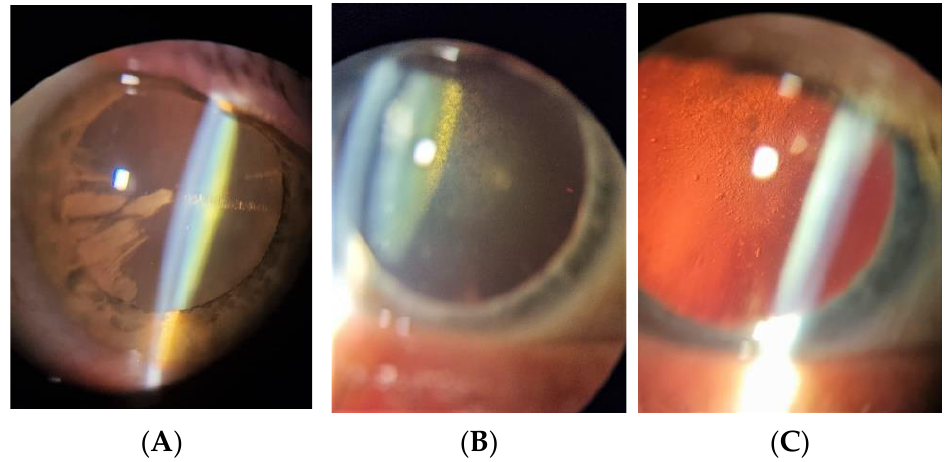
Figure 1. Cataracts related to diabetes. ( A ) Cortical cataract. ( B ) Posterior subcapsular cataract. ( C ) Posterior subcapsular cataract in retroillumination.